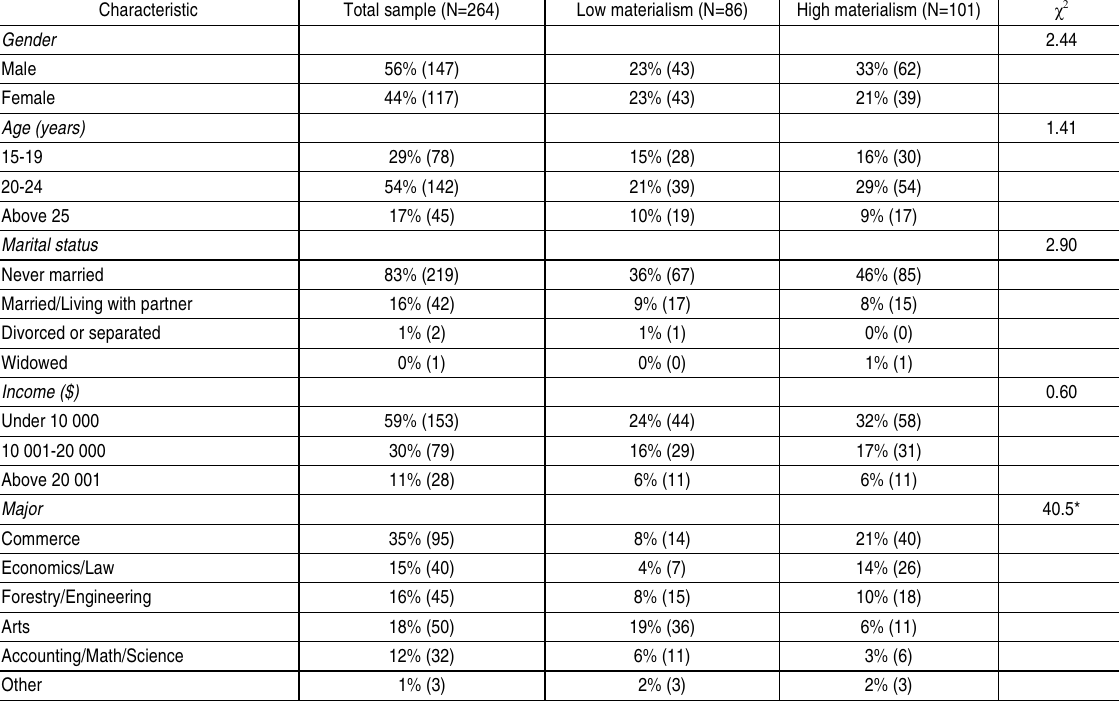
Table 2. Demographic characteristics for the sample, low materialism, and high materialism respondents